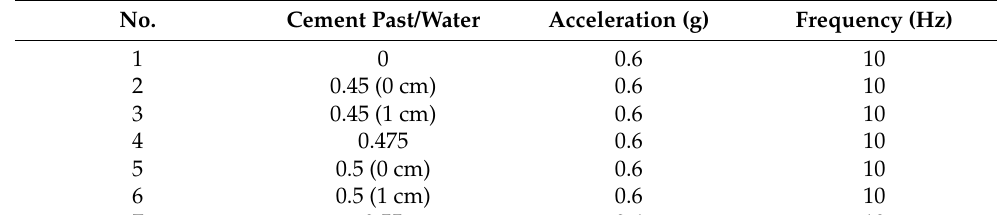
Table 2. Characteristics of experiments.